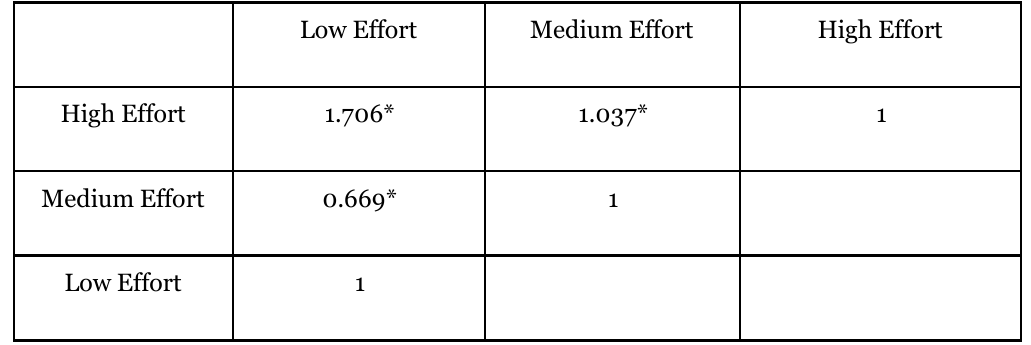
Scheffe Test for the Medium EL Group (N = 525)